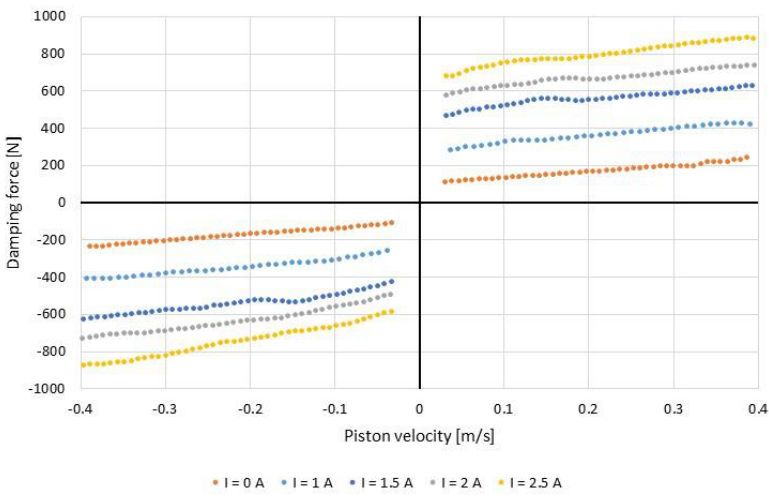
Figure 4. F – V characteristics of the damper.